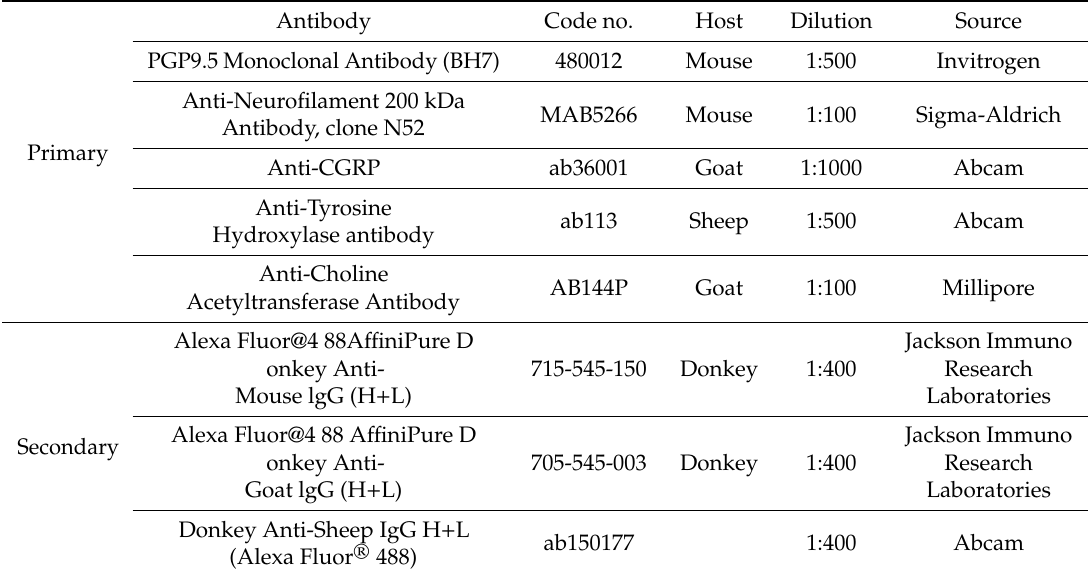
Table 1. Primary and secondary